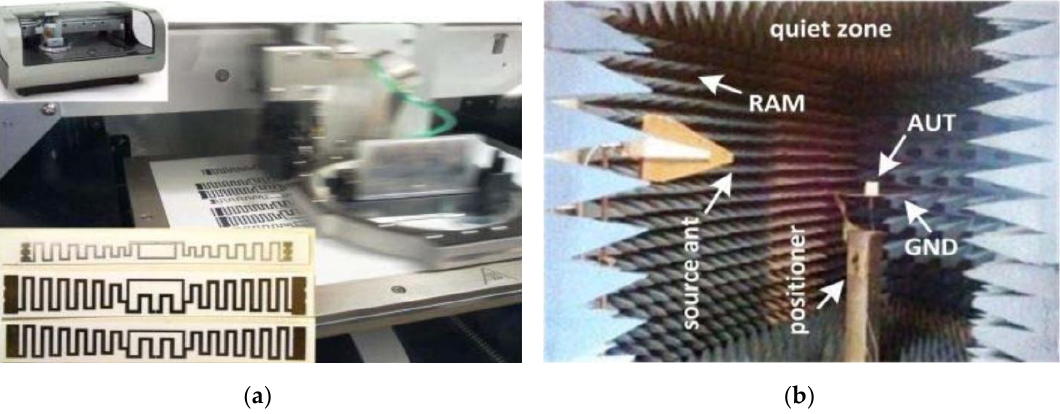
Figure 11. ( a ) Inkjet printing setup and paper substrate printed antennas; ( b ) Experimental setup in an anechoic chamber [16].